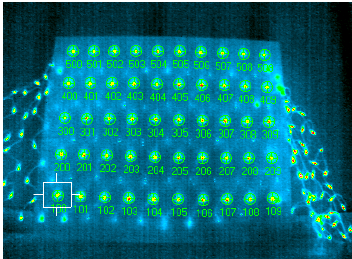
Figure 3: One infrared image of the calibration grid with marked tie